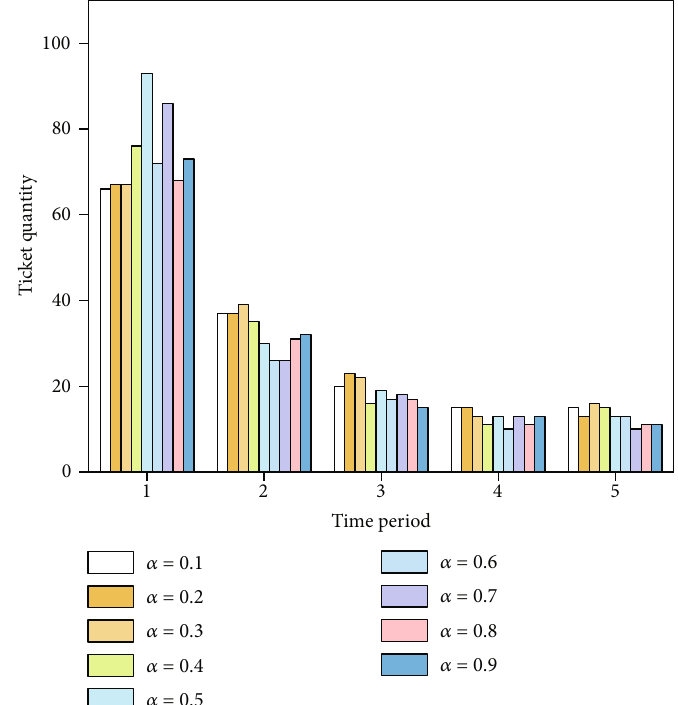
Figure 11: Ticket quantity of train A in OD 2.